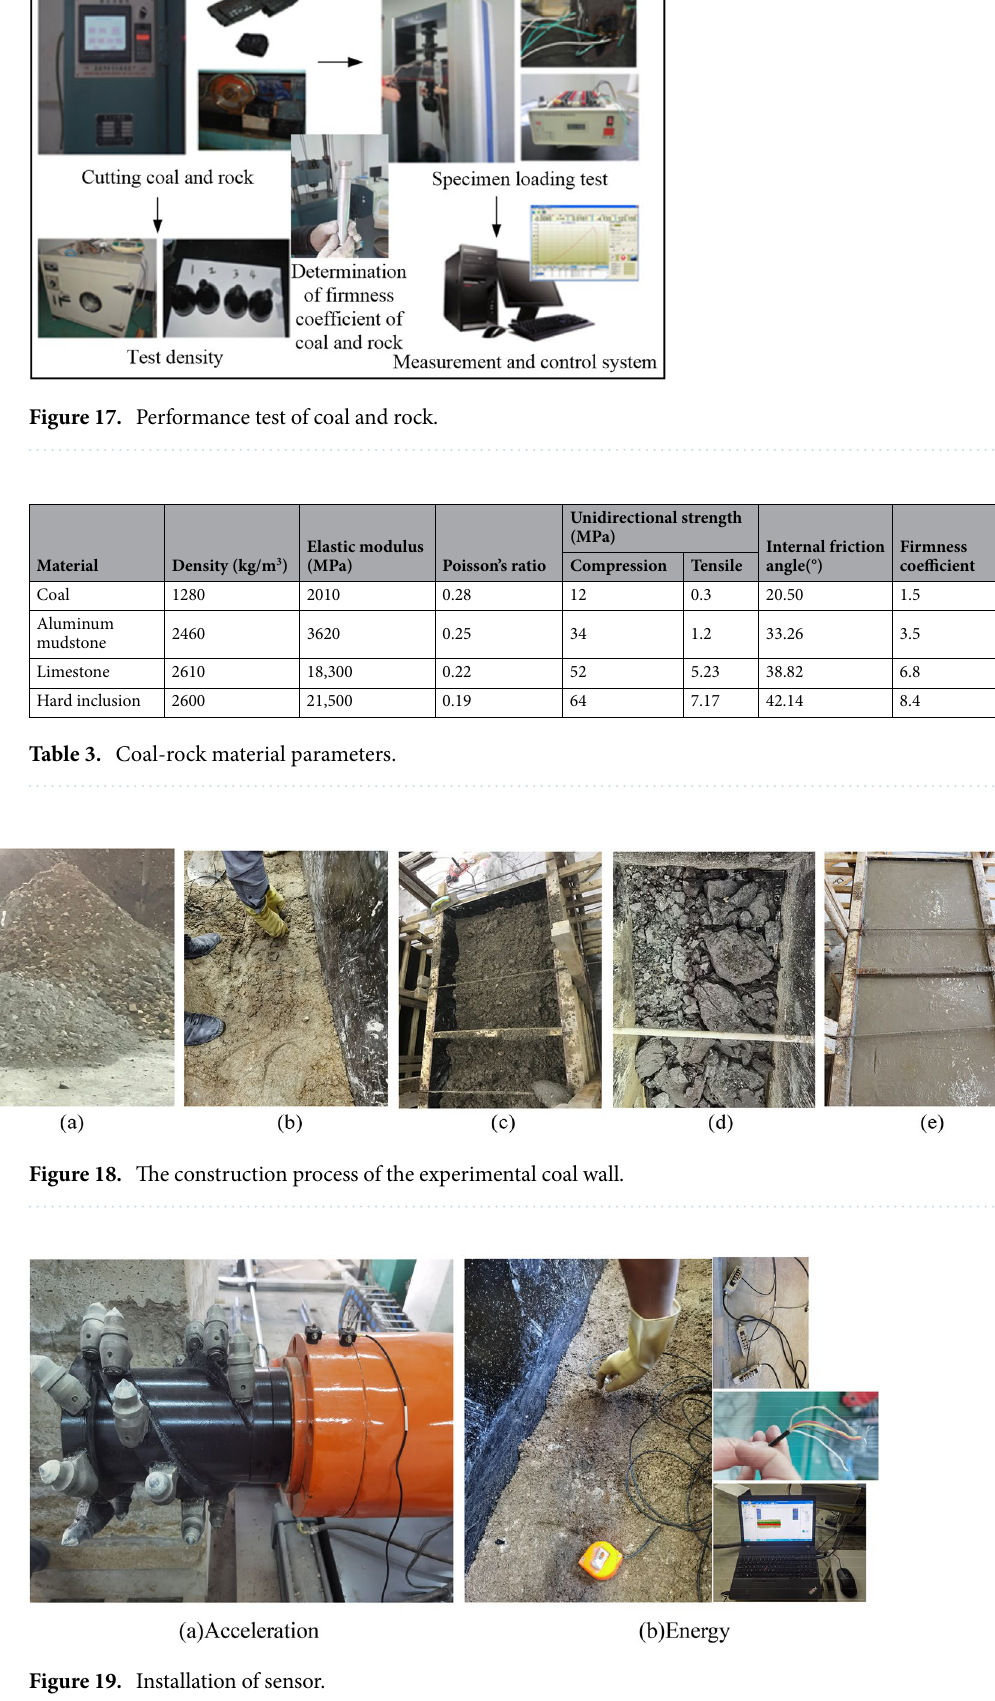
Figure 19. Installation of